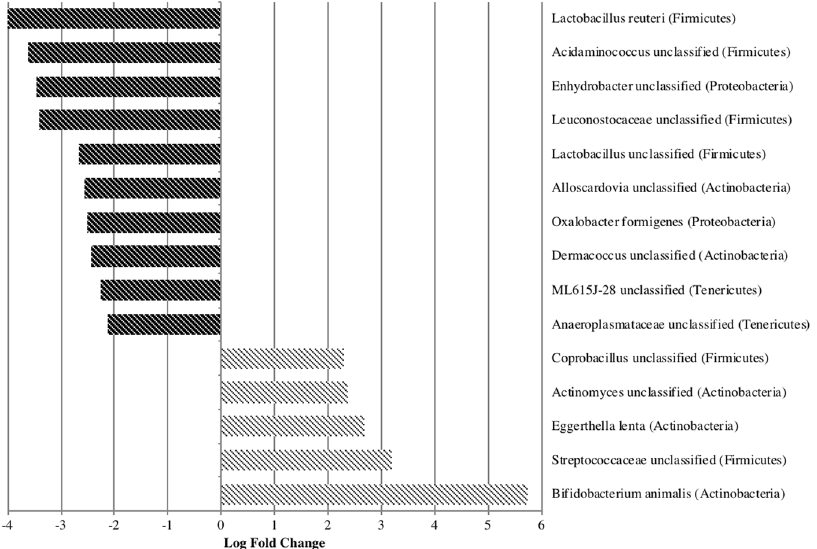
Figure 5. EdgeR analysis (negative binomial GLM) identified several taxa that significantly contributed (q < 0.1) to differences between post-cricket and control